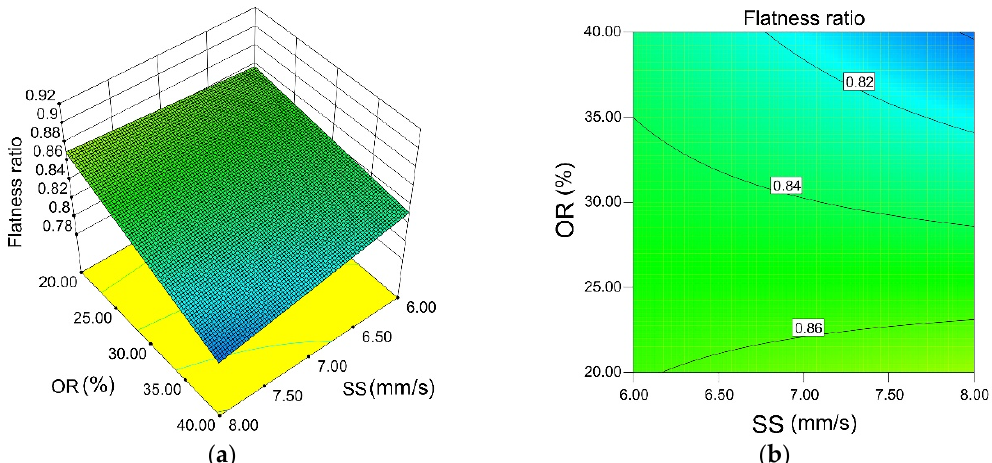
Figure 6. ( a ) Response surface of scanning speed and overlap ratio interaction affecting the flatness ratio; ( b ) Contour line of the response surface.